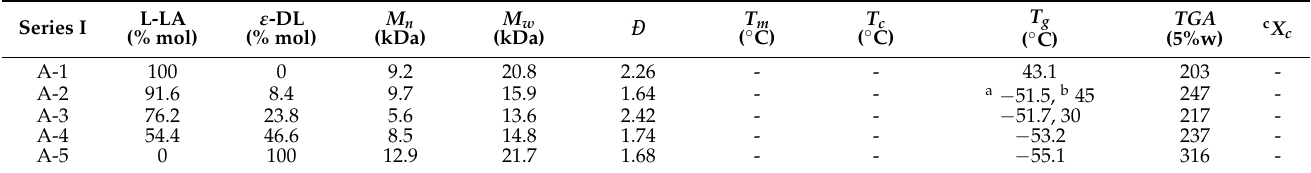
Table 1. Comonomer molar percentage, M n , M w ,